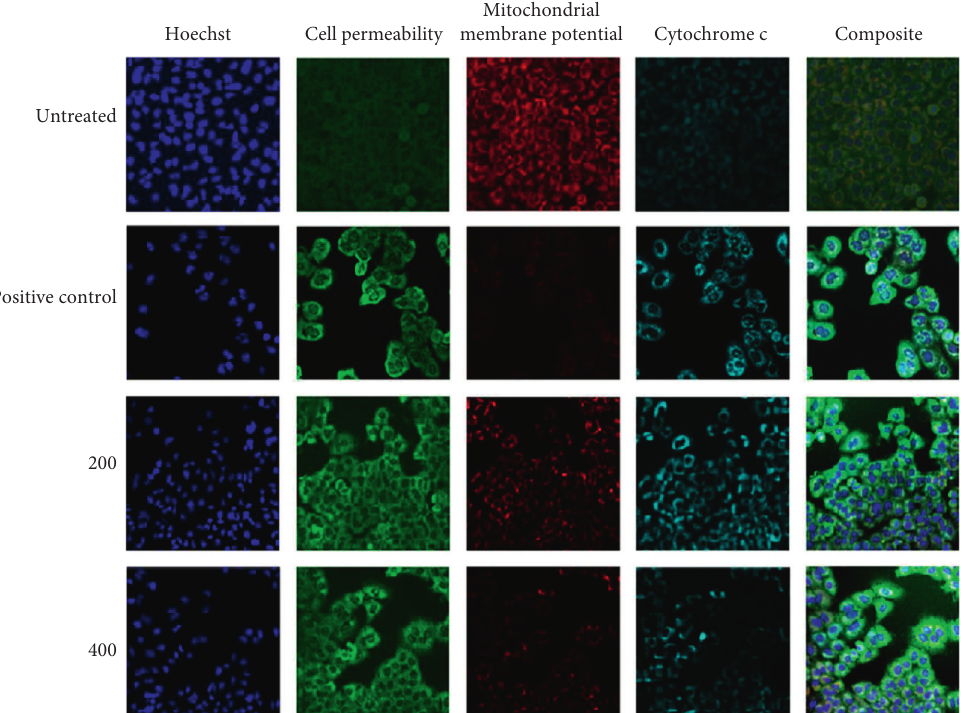
Figure 13: Multiparameter cytotoxicity analysis of A549 cells treated with the NPs synthesized under the presence of magnetic field at 60mJ/cm 2 . Doxorubicin was the positive control (1mM) at 200 µ gmL − 1 , and 400 µ g mL − 1